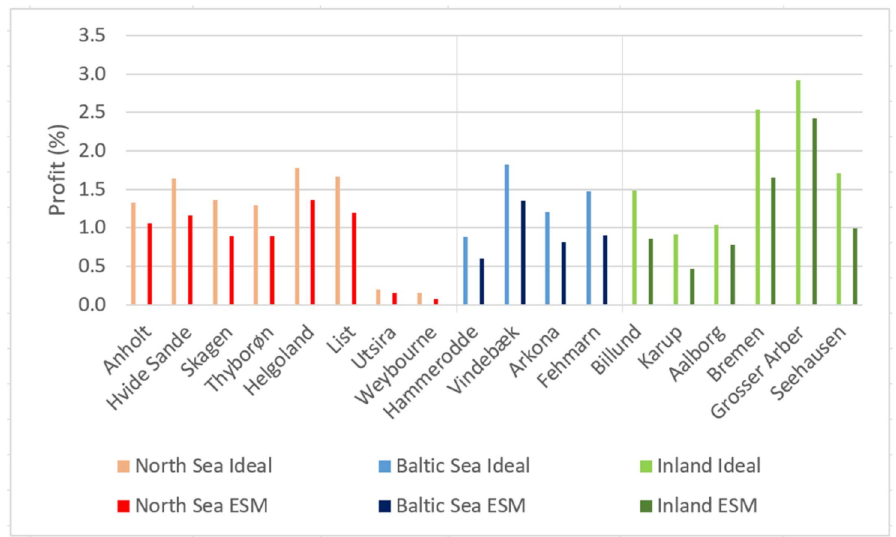
Figure 9. The profit (in %) from ideal blades and profit from site-specific optimized erosion-safe mode (ESM) compared to the default case for each station. Table 3. The profit (in %) for ideal vs. default operation, profit for erosion-safe mode (ESM) with the same threshold values for all stations vs. default operation, and profit for ESM with site-specific optimization vs. default operation. Profit Site-Specific Ideal vs. Default Profit ESM vs. Area Station Optimized ESM vs. Profit (%) Default (%) Default (%)